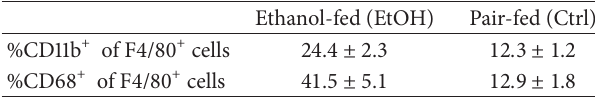
Table 3: CD11b and CD68 expression of F4/80 + cells in the